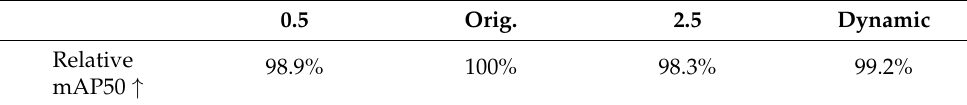
Table 1. Gamma Correction: impact on the performance.